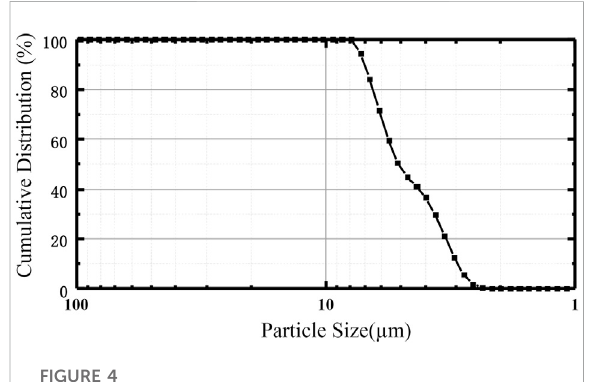
FIGURE 4 The particle size distribution of fi ne-grained tailings.